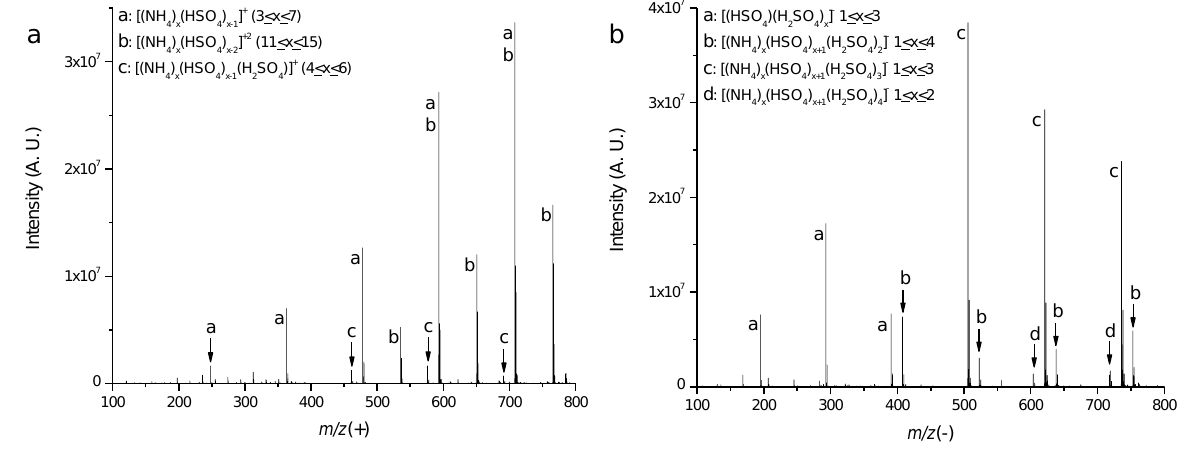
Fig. 1. Electrospray ionization mass spectra of an ammonium sulfate solution in (a) positive and (b) negative modes.